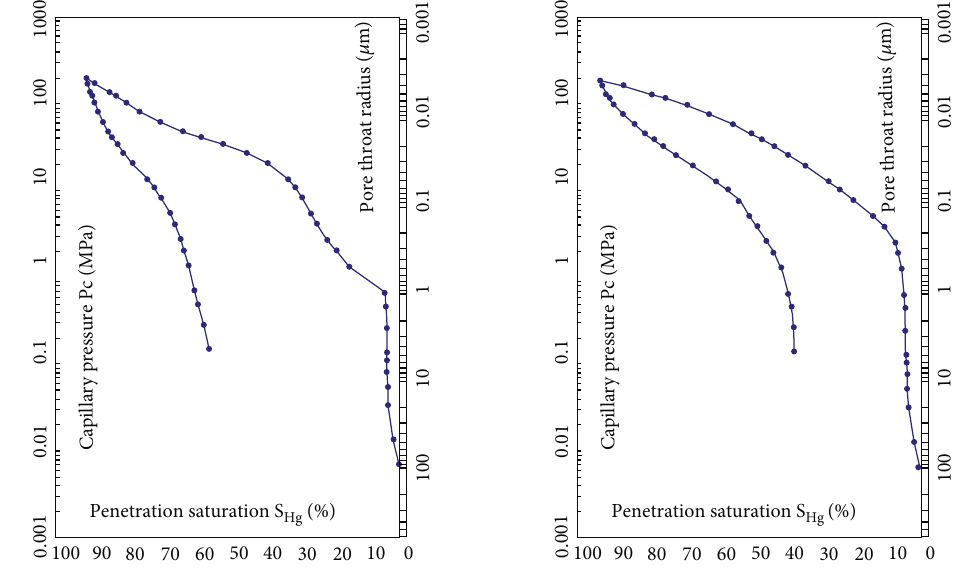
Figure 3: Capillary pressure curves of faulted strata in the Longfengshan area ((a) Yingcheng Formation; (b) Shahezi Formation).